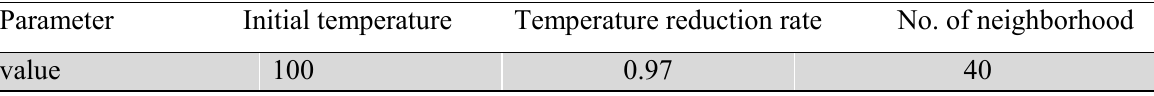
Parameter settings of SA.